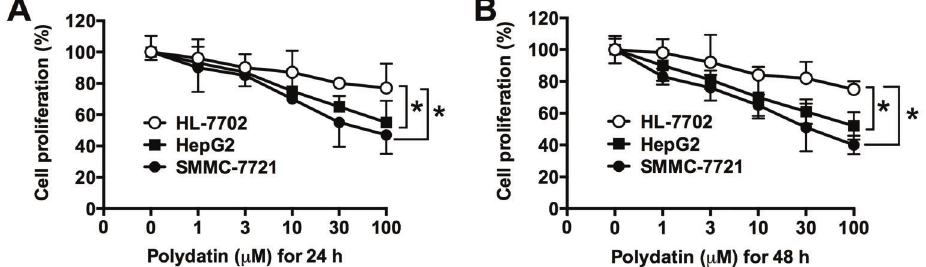
Figure 1. Effects of polydatin on cell proliferation in normal liver cell lines and liver cancer cell lines. A , Different concentrations of polydatin for 24 h, and B , for 48 h determined by MTTassay. Data are reported as means ± SD. All experiments were repeated 3 times. *P o 0.05 compared to control (HL-7702 group) (two-way